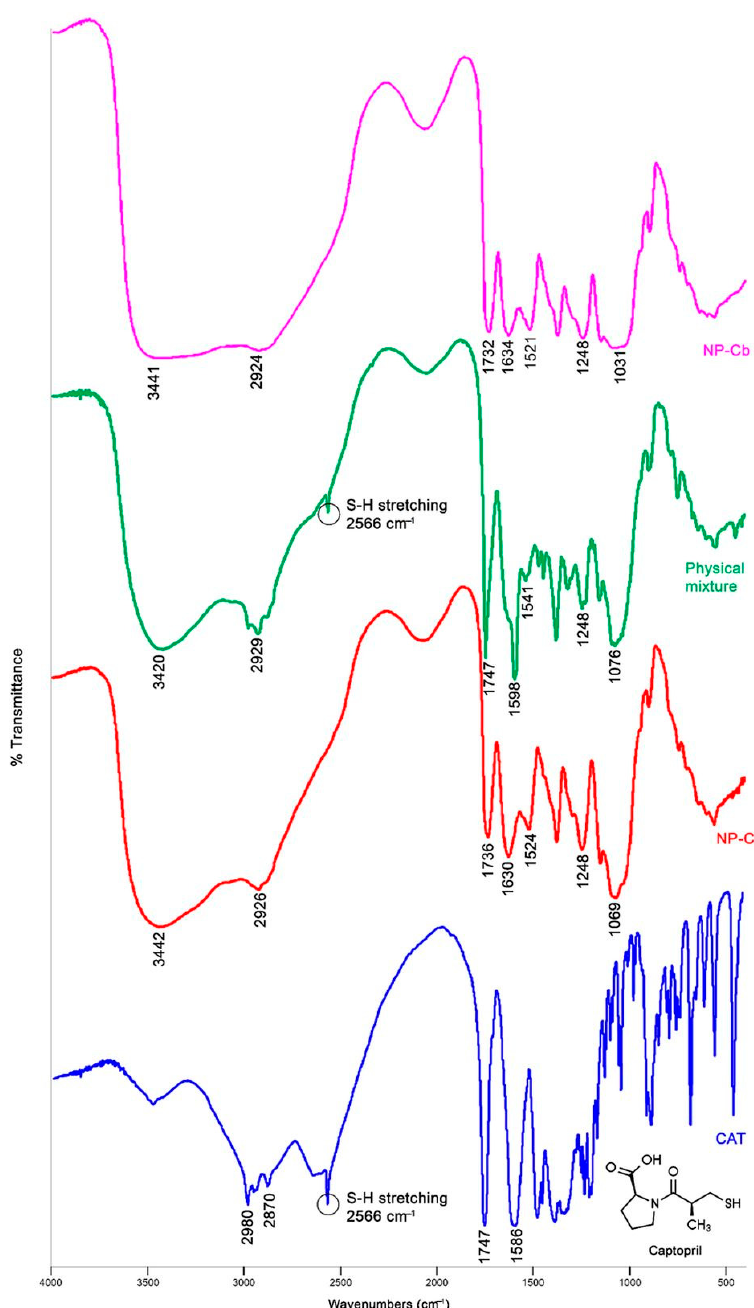
Figure 3. FTIR spectra of CAT, NP-C, NP-Cb and the physical mixture.